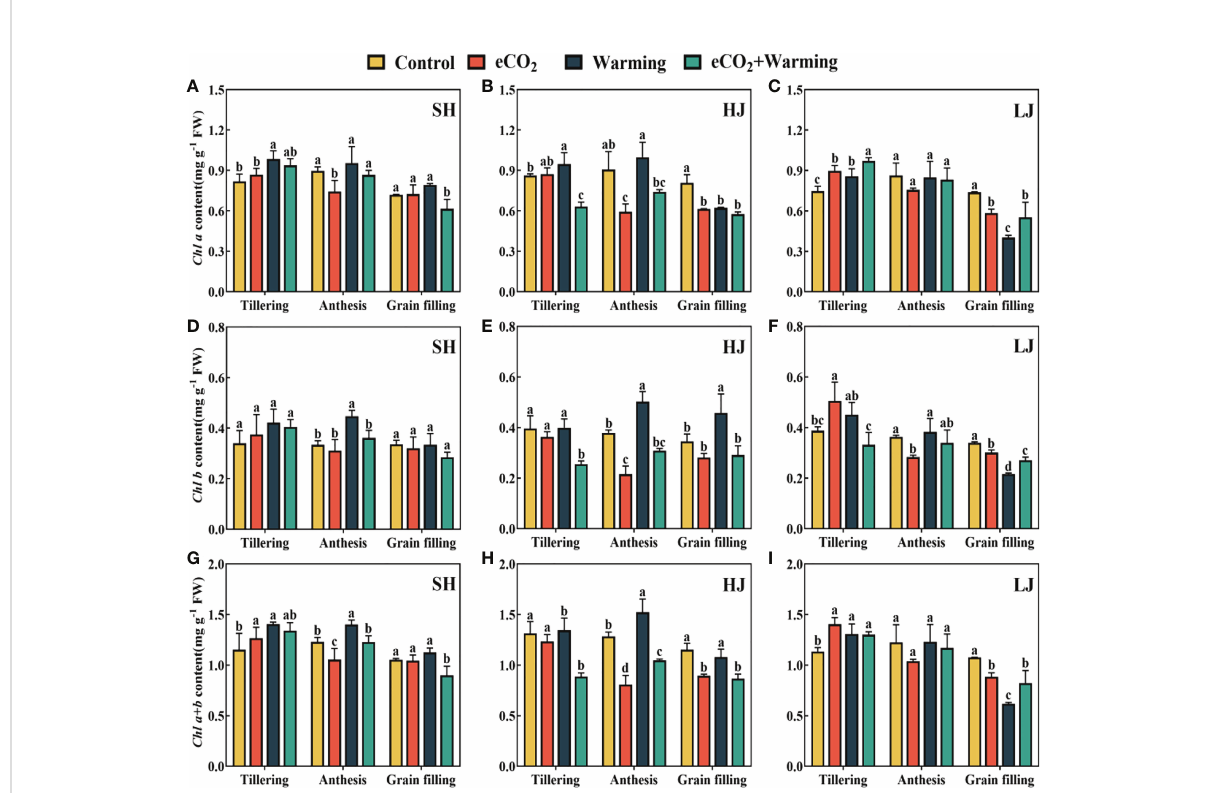
FIGURE 6 The leaf chlorophyll a ( Chl a , A-C ), chlorophyll b ( Chl b , D-F ) and chlorophyll a+b ( Chl a+b , G-I ) under control, ambient conditions; e[CO 2 ], elevated [CO 2 ] concentration; warming, elevated air temperature; e[CO 2 ] plus warming, the combination of elevated air temperature and [CO 2 ]) at the growth stage of tillering, anthesis and grain fi lling. SH, HJ and LJ refer to three rice cultivars Shishoubaimao, Hejiang 19, and Longjing 31, respectively. Values are the means ± SEs (n =6 ).Different lower-case letters indicate signi fi cant differences between treatments at P < 0.05